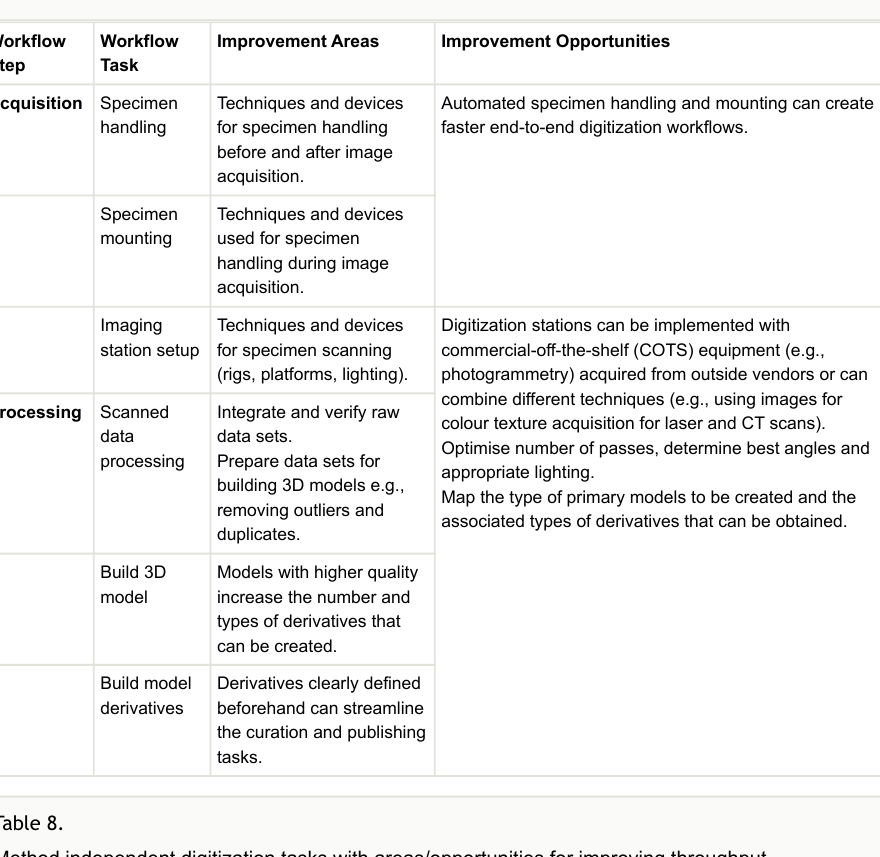
Method independent digitization tasks with areas/opportunities for improving